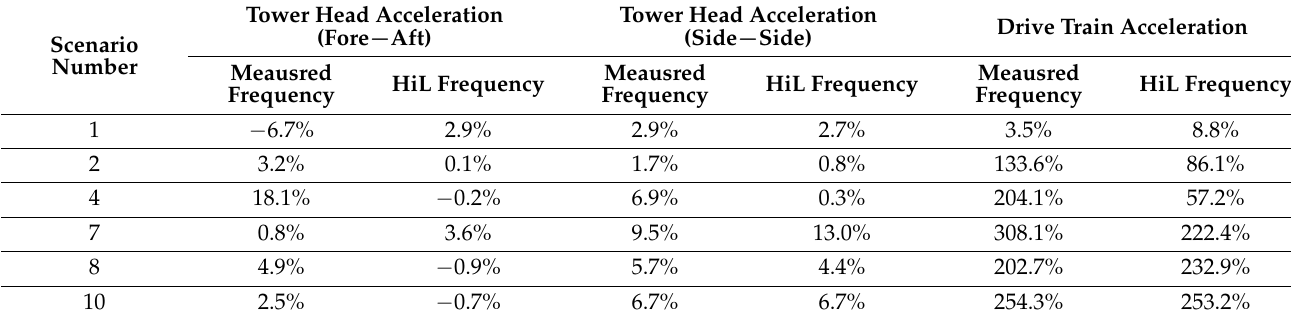
Table 3. Change of the standard deviation of the analyzed acceleration signals for six scenarios. Scenario